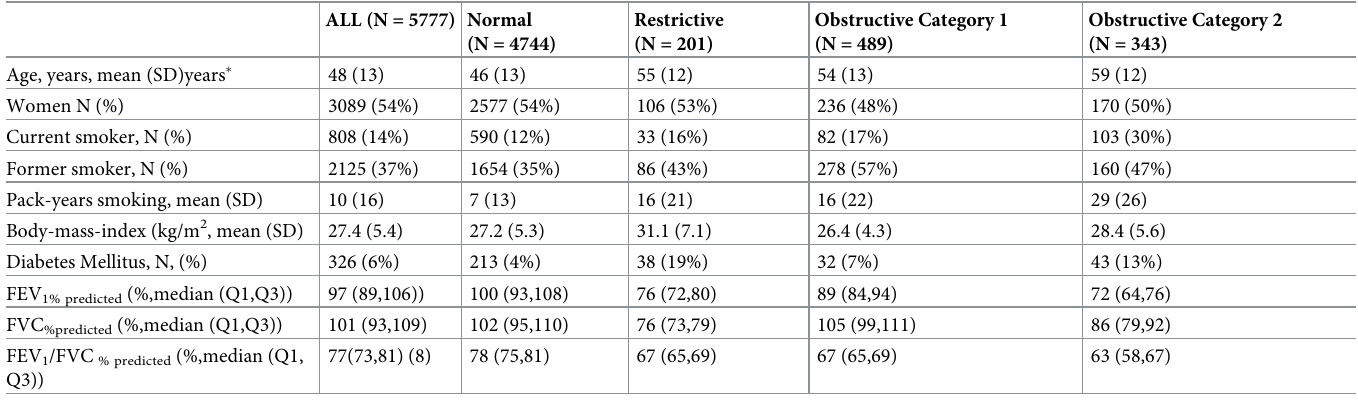
Table 1. Clinical characteristics of 5777 FHS participants at baseline.